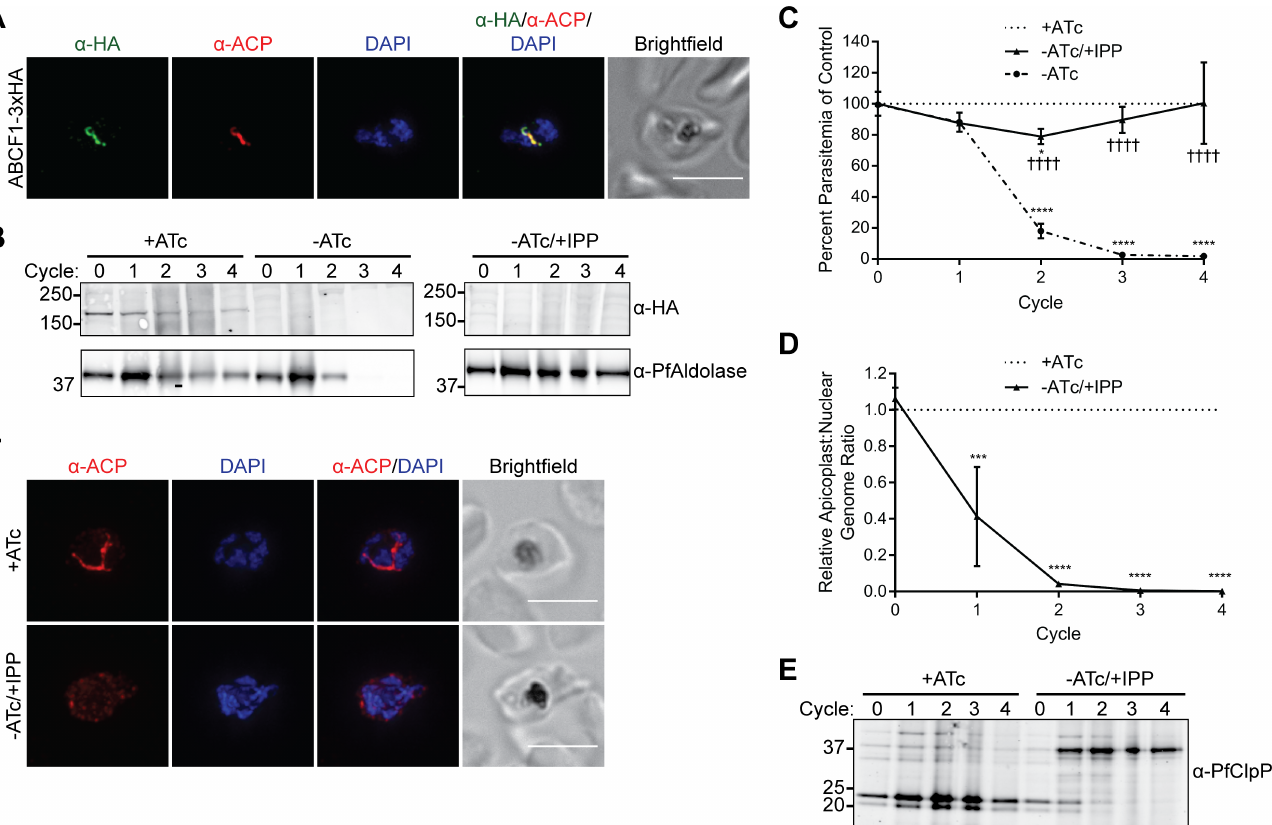
Fig 8. ABCF1 is an essential apicoplast protein required for organelle biogenesis. (A) Fixed-cell imaging of ABCF1-3xHA knockdown parasites stained with antibodies raised against the HA tag and the apicoplast marker ACP. Scale bar, 5 μ m. (B-F) ABCF1-3xHA knockdown parasites were grown in the presence of ATc (+ATc), the absence of ATc (-ATc), or the absence of ATc with IPP supplementation (-ATc/+IPP) for 4 growth cycles. (B) Western blot of ABCF1-3xHA expression. (C) Parasite growth. At each time point, data are normalized to the untreated (+ATc) control. Error bars represent standard deviation of the mean of 2 biological replicates. (cid:3) P < 0.05, (cid:3)(cid:3)(cid:3)(cid:3) P < 0.0001 compared to untreated control, †††† P < 0.0001 compared to -ATc condition, repeated measures two-way ANOVA with Tukey’s multiple comparisons test. (D) Relative apicoplast:nuclear genome ratio as determined by quantitative PCR. At each time point, data are normalized to the untreated (+ATc) control. Error bars represent standard deviation of the mean of 2 biological replicates, each performed in technical triplicate. (cid:3)(cid:3)(cid:3) P < 0.001, (cid:3)(cid:3)(cid:3)(cid:3) P < 0.0001, repeated measures two-way ANOVA with Sidak’s multiple comparisons test. (E) Western blot of ClpP processing. (F) Fixed-cell imaging showing ACP localization after 2 cycles of knockdown. Scale bars, 5 μ m. Tabulated data for (C) and (D) are available in S1 Data. ABC, ATP-binding cassette; ACP, acyl carrier protein; ATc, anhydrotetracycline; ANOVA, analysis of variance; ClpP, caseinolytic protease subunit P; HA, hemagglutinin; IPP, isopentenyl pyrophosphate.